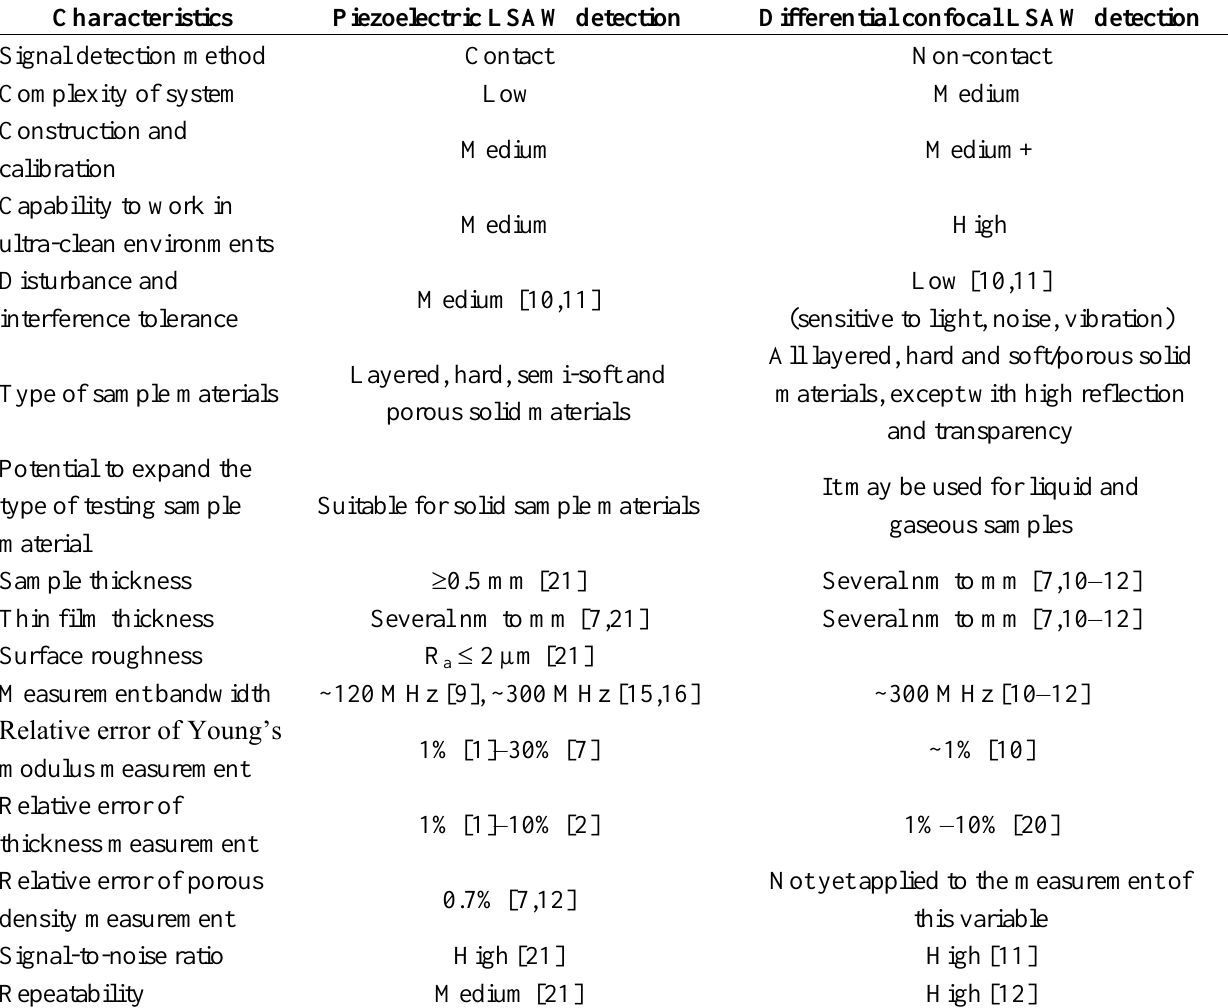
Table 1. Characteristics of piezoelectric and differential confocal LSAW detection